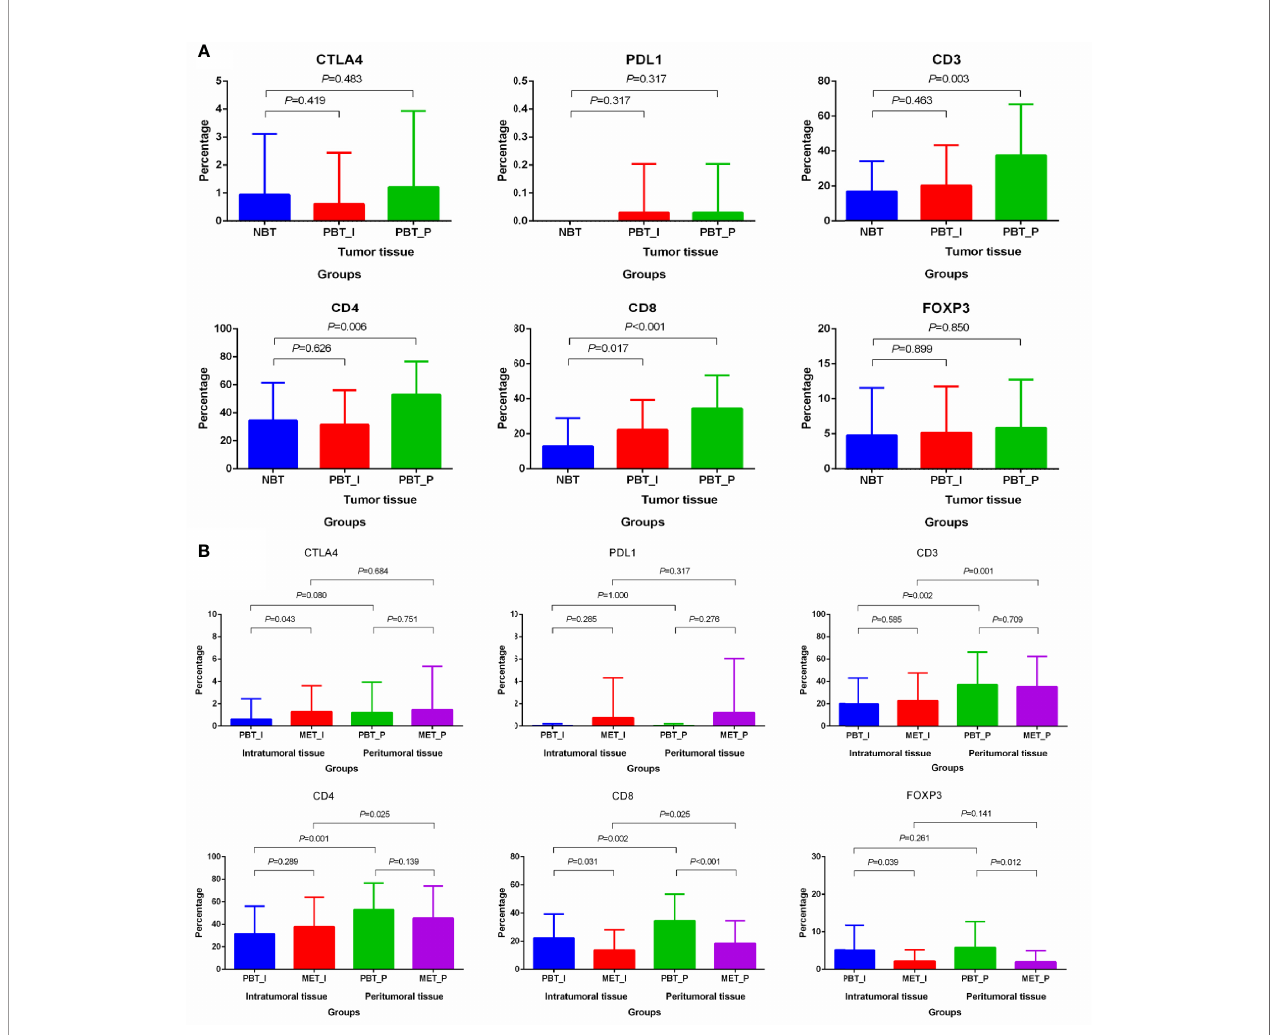
FIGURE 3 | Differential distribution of immune markers in matched normal breast tissues, primary cancers and oligometastatic lesions. (A) Differential distribution of immune markers in normal tissue and primary lesions. (B) Differential distribution of immune markers in primary and metastatic lesions. NBT, normal breast tissue; PBT_I, intratumoral regions of primary breast tissue; MET_I, intratumoral regions of oligometastatic lesions; PBT_P, peritumoral regions of primary breast tissue; MET_P, peritumoral regions of oligometastatic